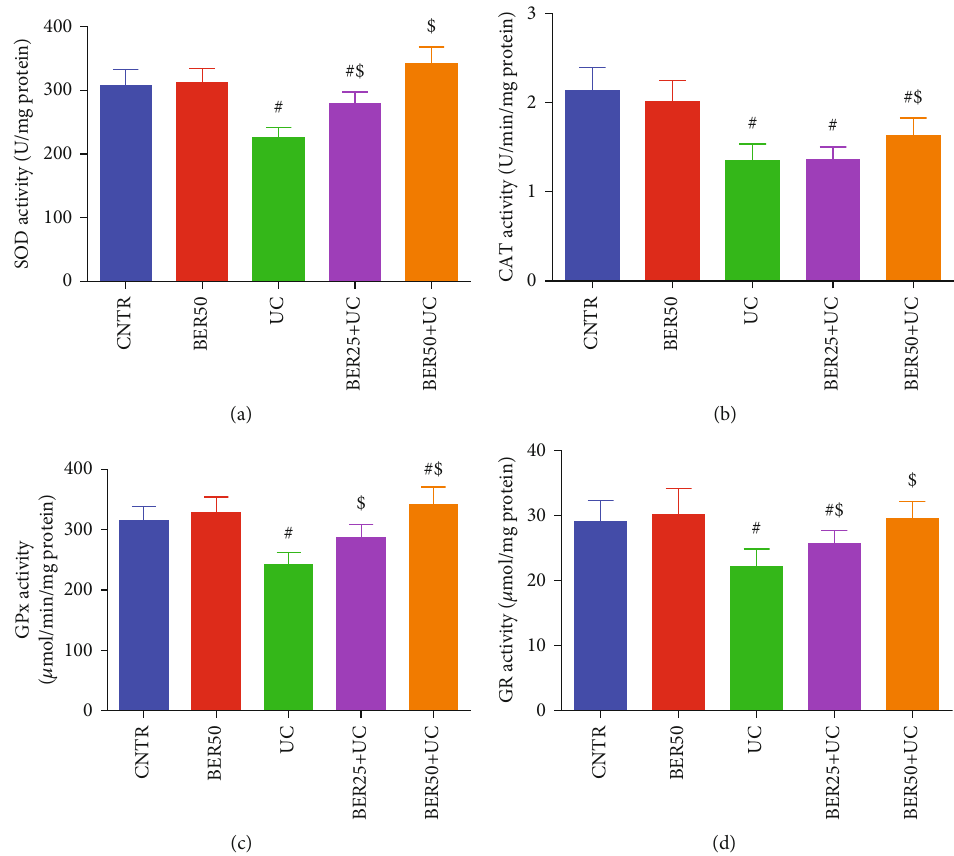
Figure 4: E ff ect of berberine at di ff erent doses on antioxidant enzymes activity ((a) SOD, (b) CAT, (c) GPx, and (d) GR) in colonic tissue of experimental colitis in rats. The results are expressed as the mean ± SD ( n = 7 ). # p < 0 : 05 compared to the CNTR group (intact group); $ p < 0 : 05 compared to UC-untreated group.